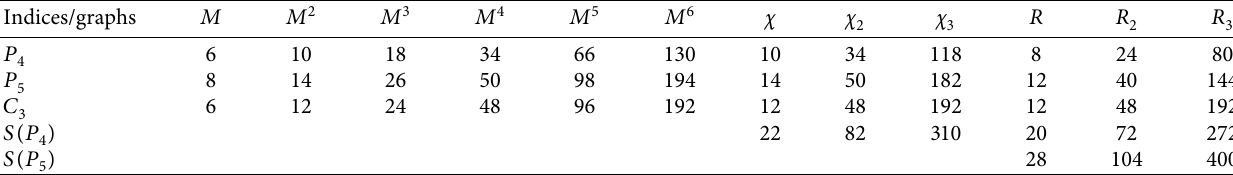
Table 1: Some particular indices of certain graphs.